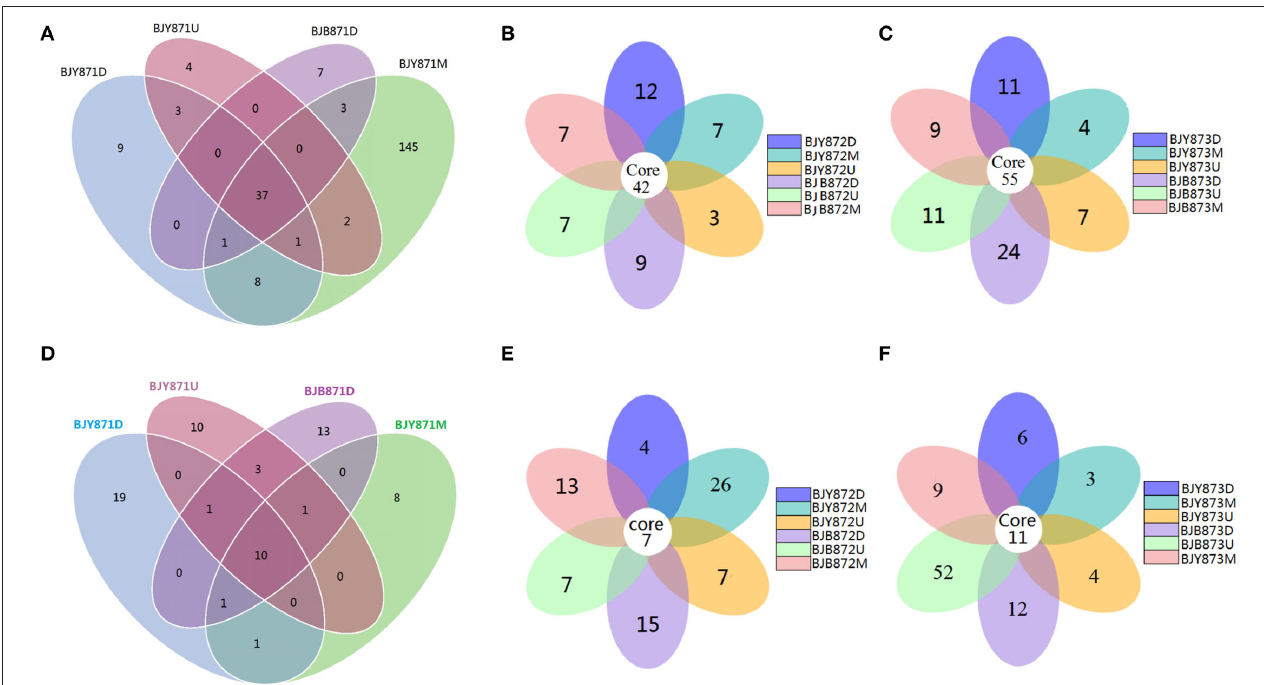
FIGURE 2 | Venn diagram showing the number of operational taxonomic units (OTUs) detected in healthy and diseased tobacco leaves. Fungal Venn diagram in healthy and diseased groups from three positions (A–C) . Bacterial Venn diagram in healthy and diseased groups from three positions (D–F) .